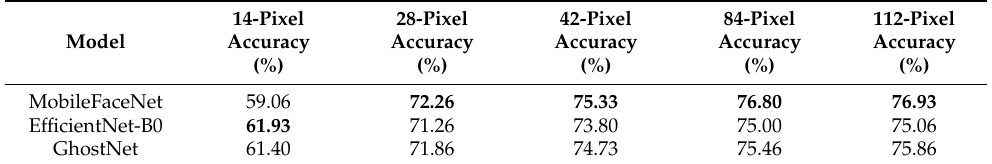
Table 10. Verification performance of the five resolution levels with the proposed evaluation